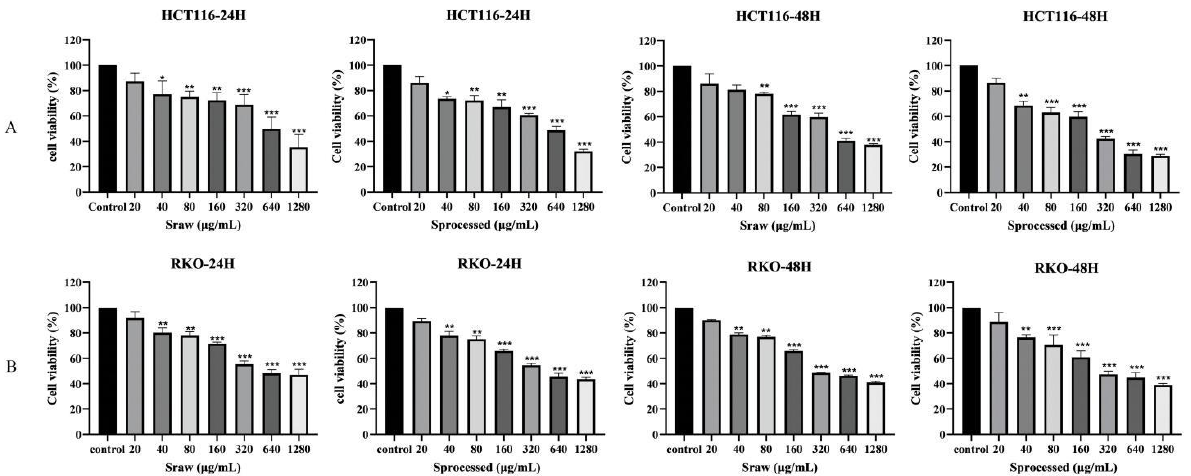
Figure 9. Sraw and Sprocessed inhibited the proliferation of human colon cancer cells. ( A ): Inhibition of the proliferation of HCT 116 colon cancer cells by different concentrations of Sraw and Sprocessed ; ( B ): Inhibition of the proliferation of RKO colon cancer cells by different concentrations of Sraw and Sprocessed . Data are expressed as mean ± SEM ( n = 6); “*” indicates the difference between one group and the control group, respectively. * p < 0.05, ** p < 0.01, *** p < 0.001 vs. 0.0 μg/mL.